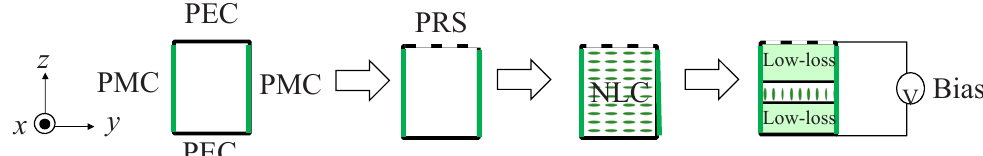
Figure 1. From left to right, an air-filled PEC/PMC waveguide, which evolves first in an open leaky waveguide where the PEC top plate is replaced by a PRS, is then entirely filled with an NLC to allow for dynamic beamsteering and, finally, is only partially filled with an NLC material to compensate for